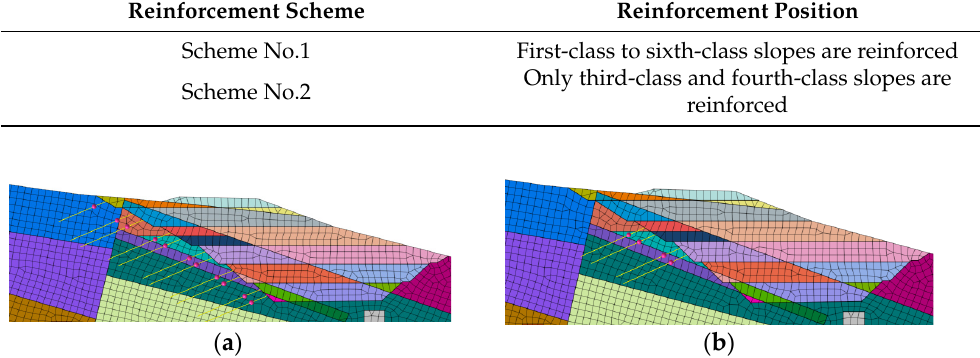
Table 15. Reinforcement scheme of the anchor cable.